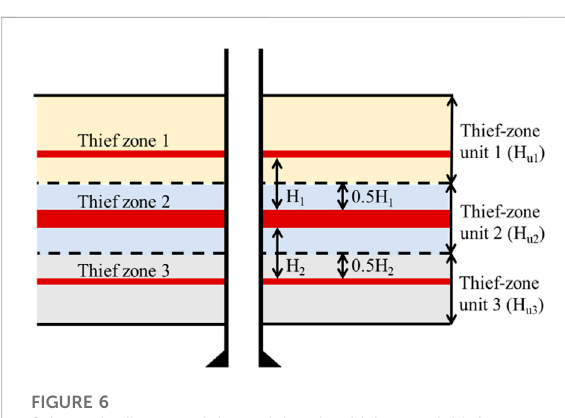
FIGURE 6 Schematic diagram of determining the thickness of thief- zone units in a member at Well